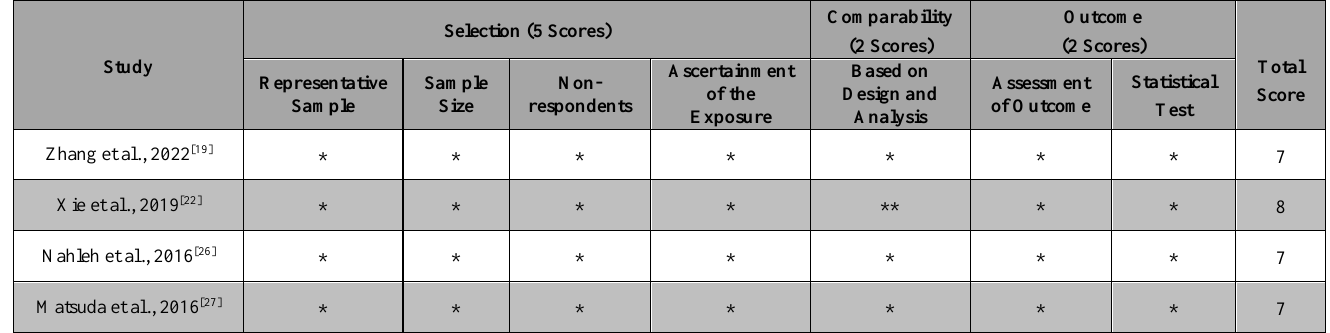
Table 3. Bias assessment (NOS